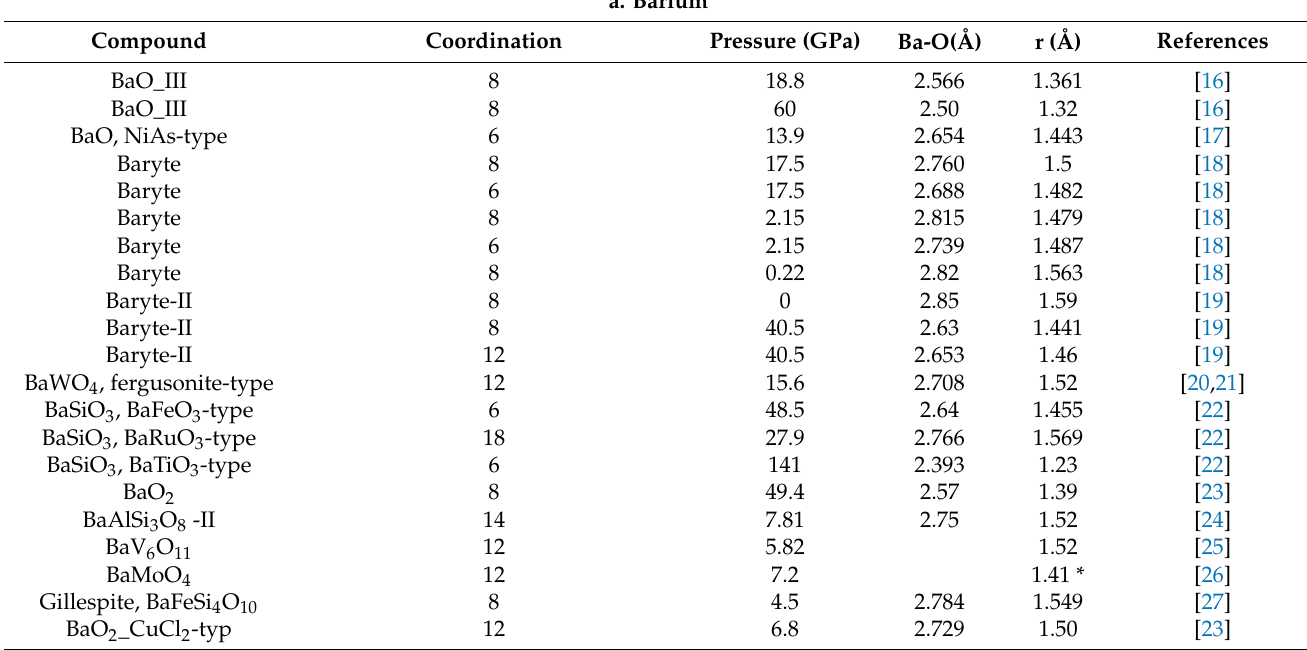
Table 1. ( a ): Crystal radii, pressures and coordination for Ba 2+ ; ( b ): crystal radii, pressures and measured average cation-oxygen bond distances for Mg and Si. The bond coordination for Si is [6], above 100 GPa possibly [8]; for Mg, the two bond coordinations [6,12] are clearly distinguished by their